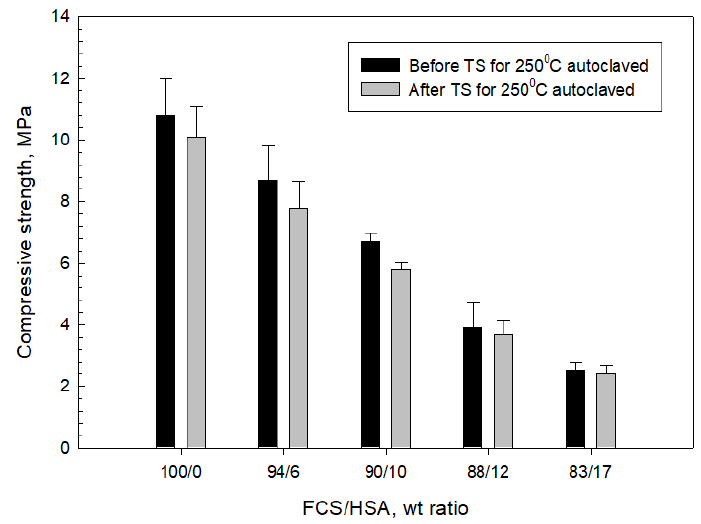
Figure 30. Compressive strength of 250 °C-autoclaved CaP cements made with different FCS/HSA ratios before and after thermal shock (TS) tests.